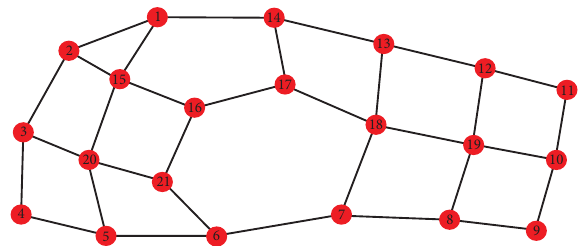
Figure 4: Node number of the road